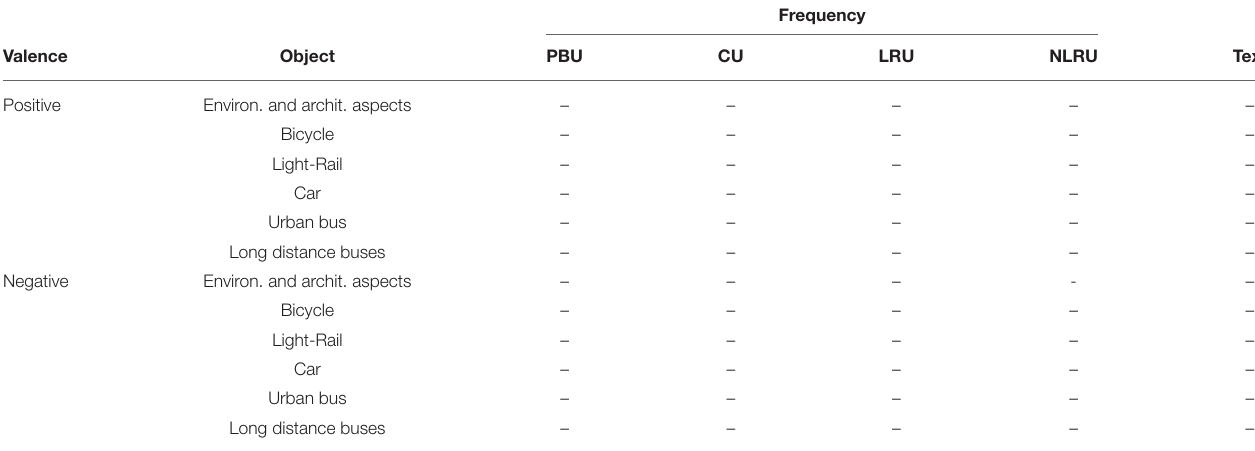
TABLE 1 | Example of coding scheme for the second type of frequency computed.